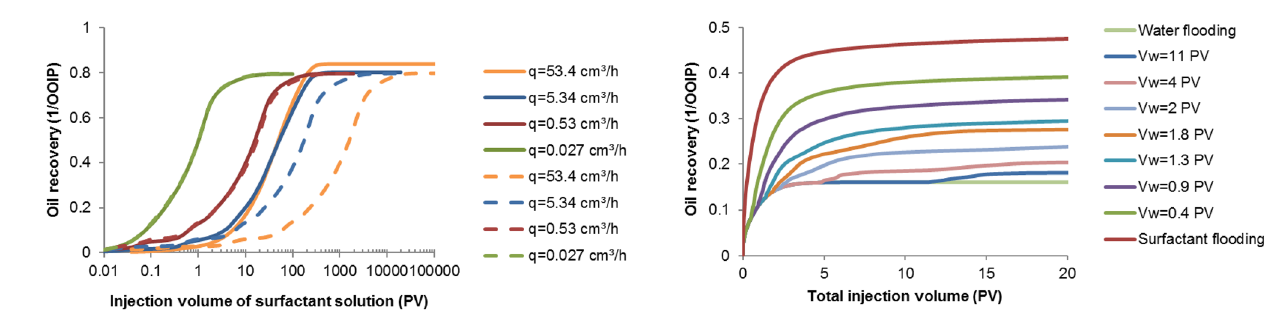
Fig. 17 Comparison of oil recovery versus injection volume curves of the base case ( ϕ f = 0.5%) and the contrastive case ( ϕ f = 0.1%). Dashed curves are oil recovery of the base case; solid curves are oil recovery of contrastive case